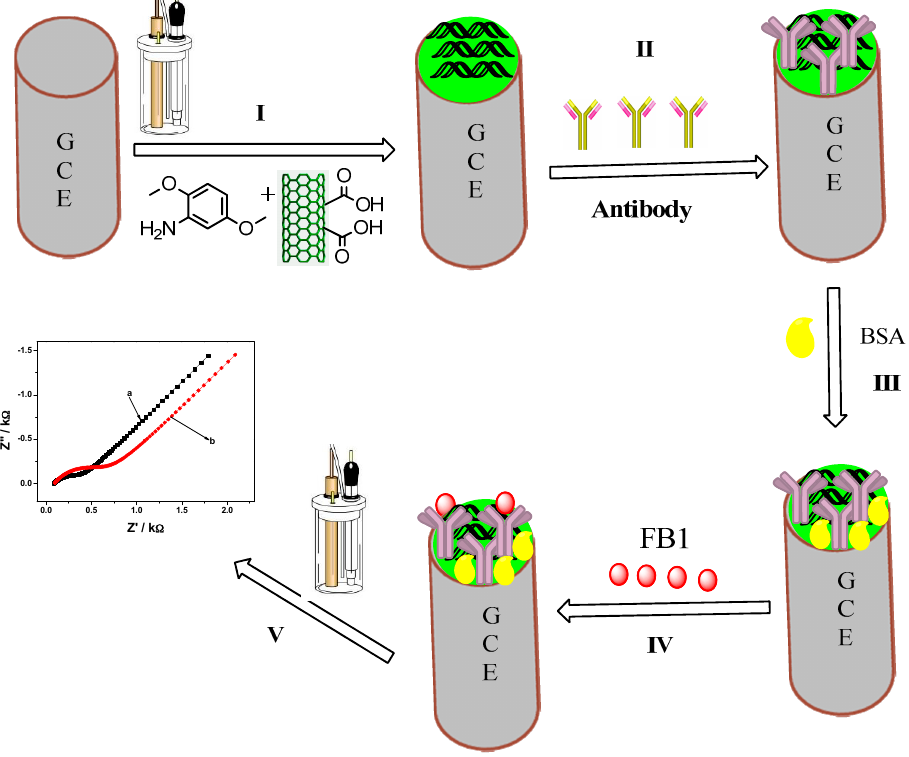
Scheme 1. Schematic representation of the synthesis of the immunosensor. ( I ) Electrochemical synthesis of PDMA-MWCNT; ( II ) attachment of antibody by drop-coating onto the electrode surface and drying for 24 h; ( III ) addition of BSA to block non-specific binding sites; ( IV ) addition of FB 1 ; ( V ) electrochemical measurements